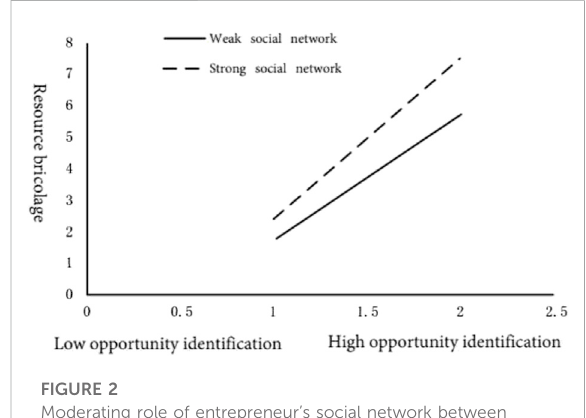
FIGURE 2 Moderating role of entrepreneur ’ s social network between social opportunity identi fi cation and resource